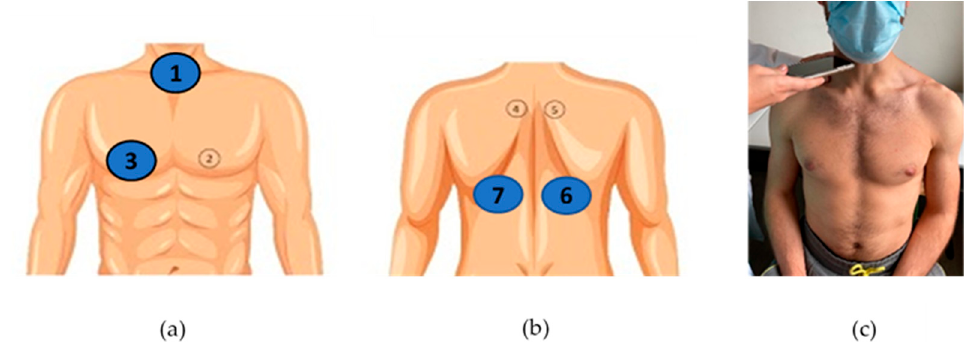
Figure 2. CORSA locations for lung sound recordings: ( a ) trachea (1) and right anterior chest (3); ( b ) right and left posterior bases (6 and 7); ( c ) example of a sound recording at the trachea during a medical appointment.